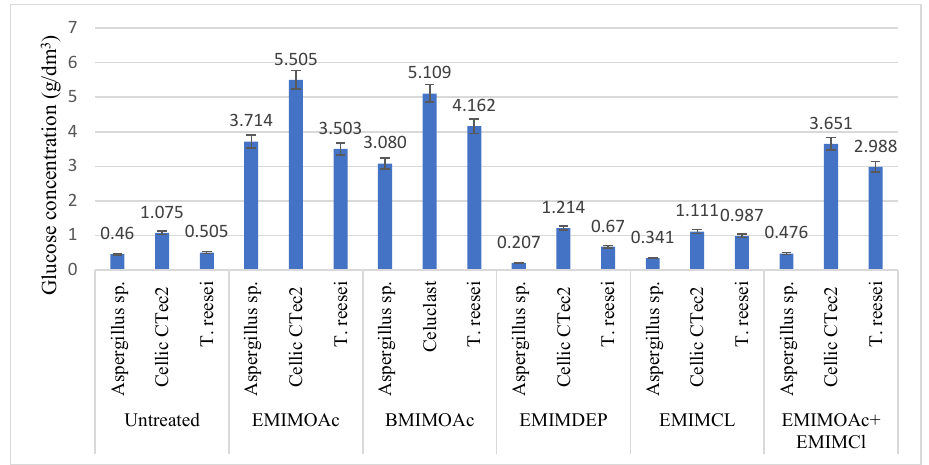
Figure 4. Glucose content after 96 h enzymatic hydrolysis of untreated buckwheat straw samples and samples treated with ionic liquids.